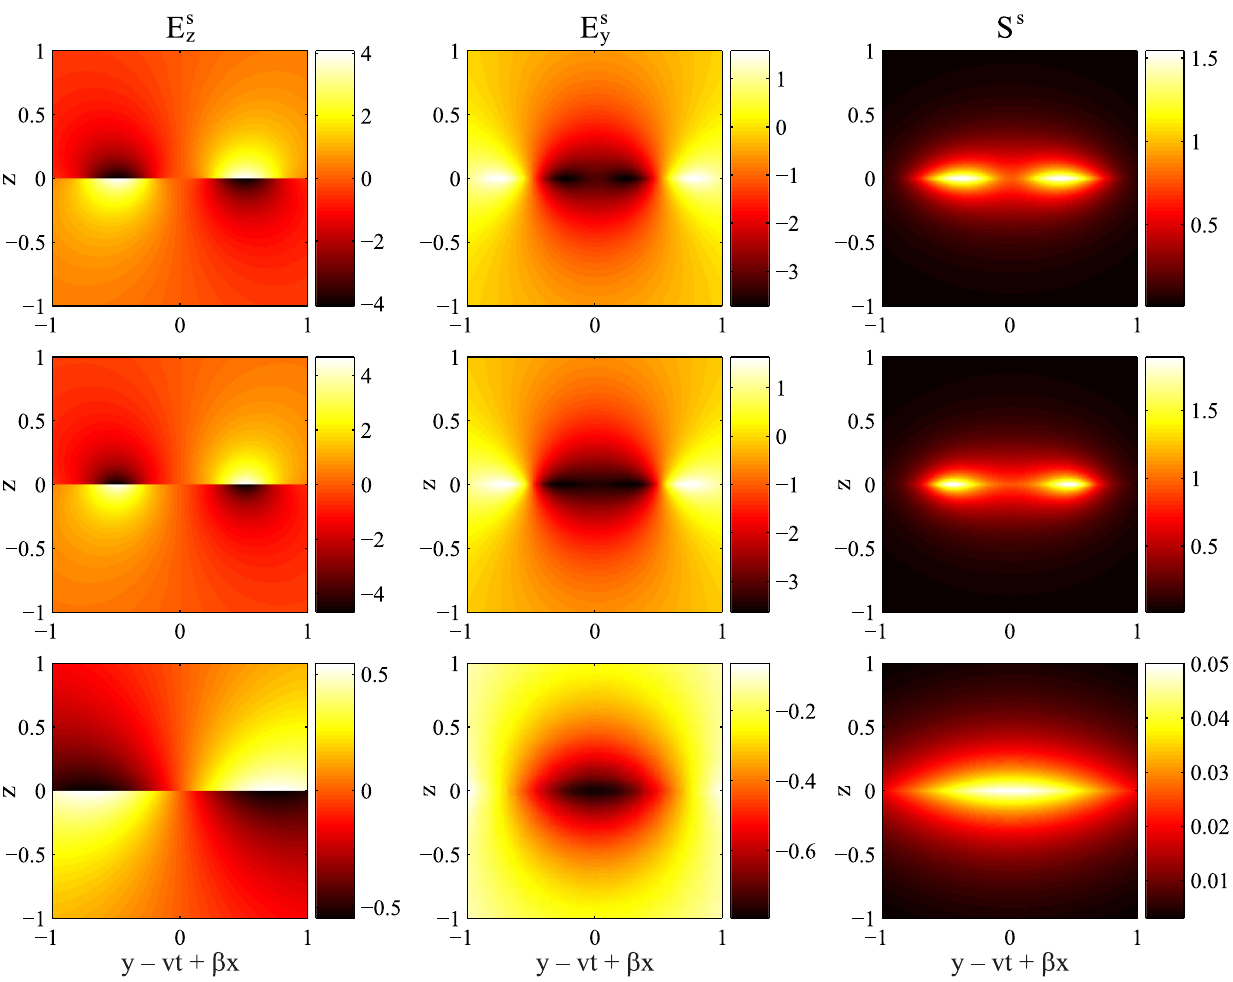
FIG. 4. The field components and the energy flow density of the surface wave from the rectangular bunch with q ¼ 1 esu moving along the wire grid. Gaussian units are used. The bunch length is 2 σ ¼ 1 cm for all pictures; ~ κ ¼ 0 . 0148 cm ( a ¼ 0 . 1 cm, r 0 . 01 cm), a 0 . 2 cm for the first row, ~ κ ¼ 0 , a 0 . 2 cm for the second row, ~ κ ¼ 0 , a 0 ¼ 0 ¼ 0 ¼ x ¼ const > 0 , and β ¼ 1 .